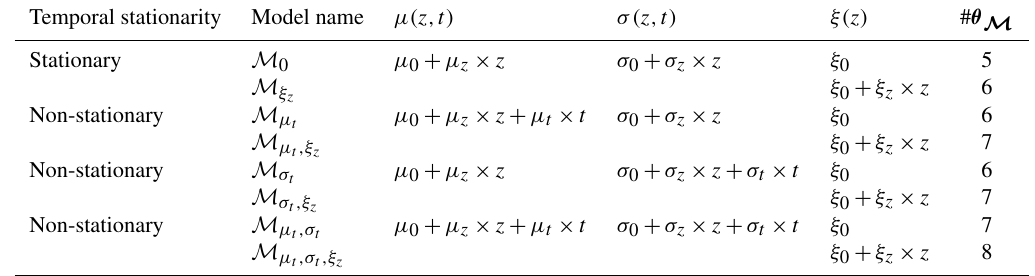
Table 2. Elevational–temporal models considered rely on the GEV distribution. For the elevational non-stationarity, the location and the scale parameters vary linearly with the elevation z , while the shape is either constant or linear with z . For temporal non-stationary models, the location and/or the scale vary linearly with time t . See Sect. 3.2 for a full description of the terms used in the table. Temporal stationarity Model name µ(z,t) σ(z,t) Stationary